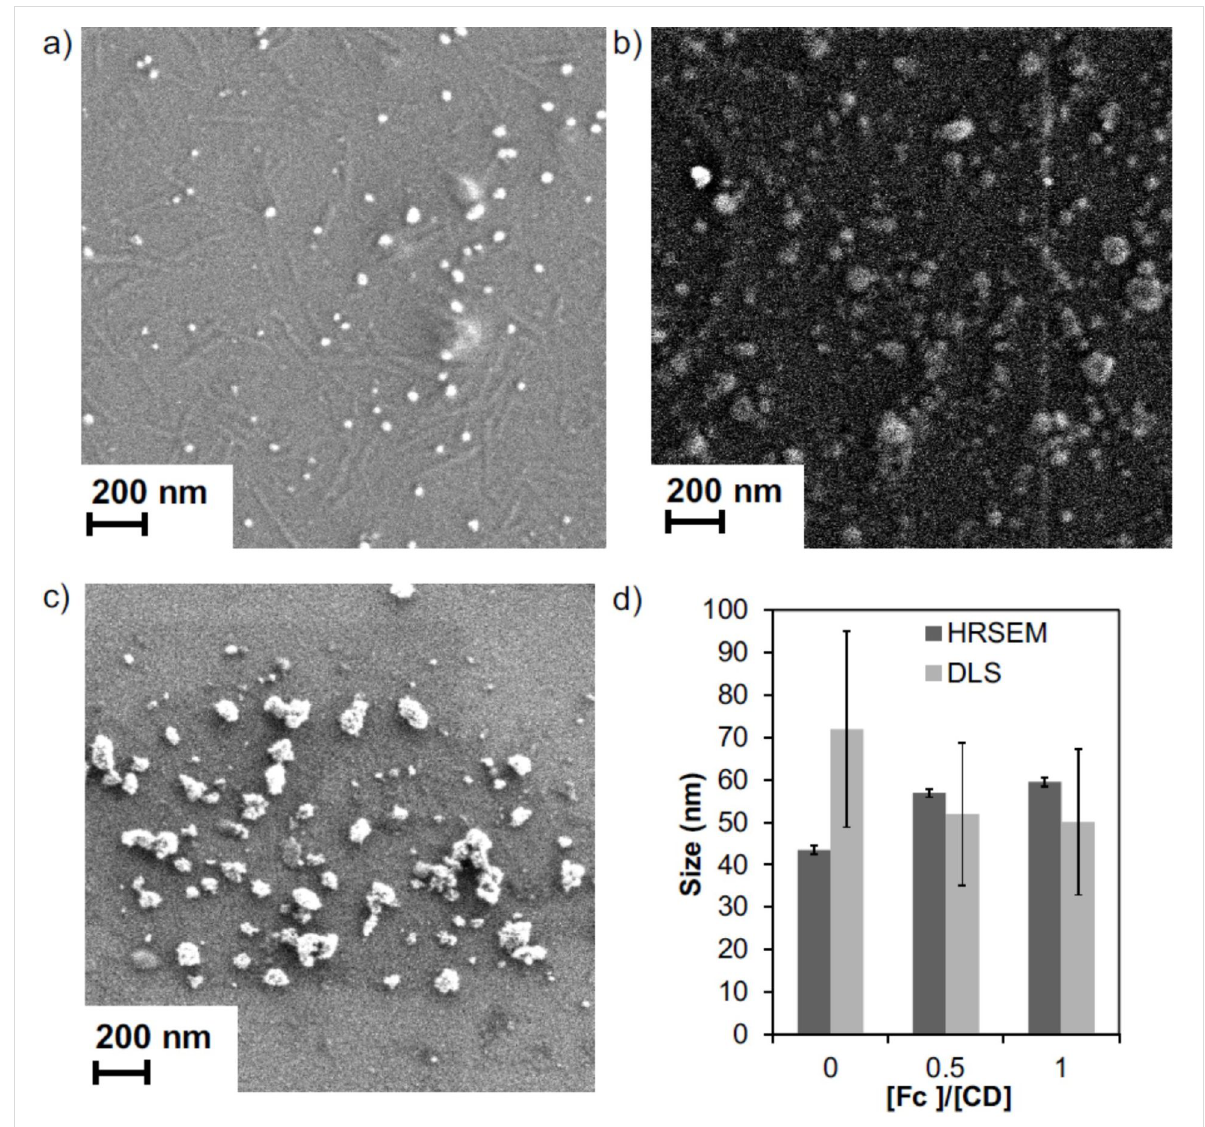
Figure 3: Size determination of SNPs prepared from CD-PEI and Fc 8 -PAMAM: SEM images (a–c) of the resulting SNPs as a function of the [Fc]/[CD] ratio (in Fc and CD moieties from Fc 8 -PAMAM and CD-PEI, respectively) in aqueous solution (without salt) (a: 0, b: 0.5 and c: 1) used during supra- molecular assembly keeping constant the total concentration using [CD] = 100 µM and d) d by DLS and size by HRSEM.